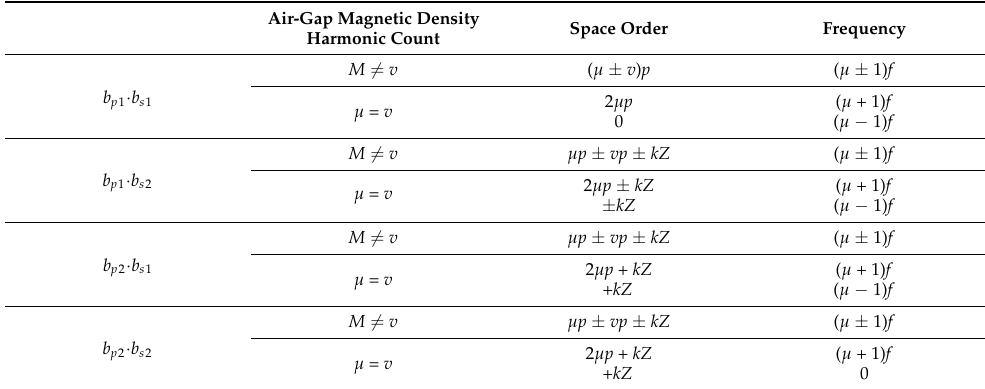
Table 2. Spatial order and frequency distribution of radial electromagnetic forces resulting from the interaction of stator and rotor’s magnetic fields.